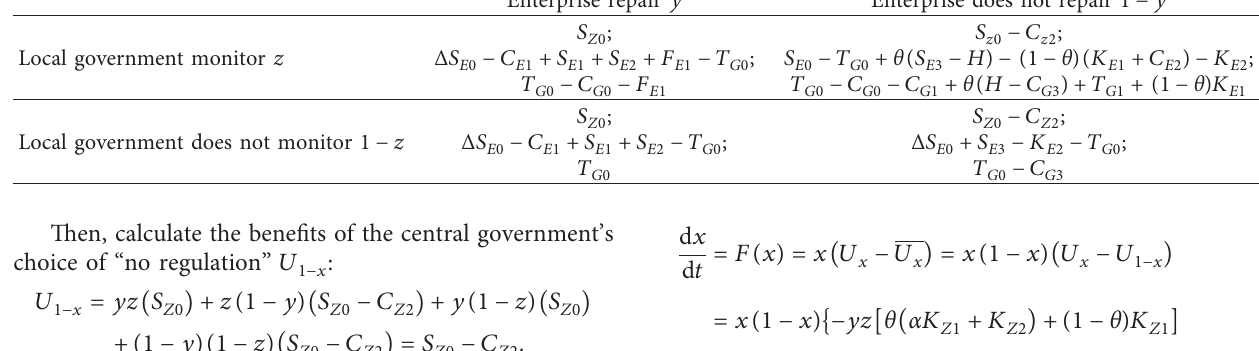
Table 2: Tripartite game strategy combinations without supervision ( 1 − x ) by the central government. Enterprise repair